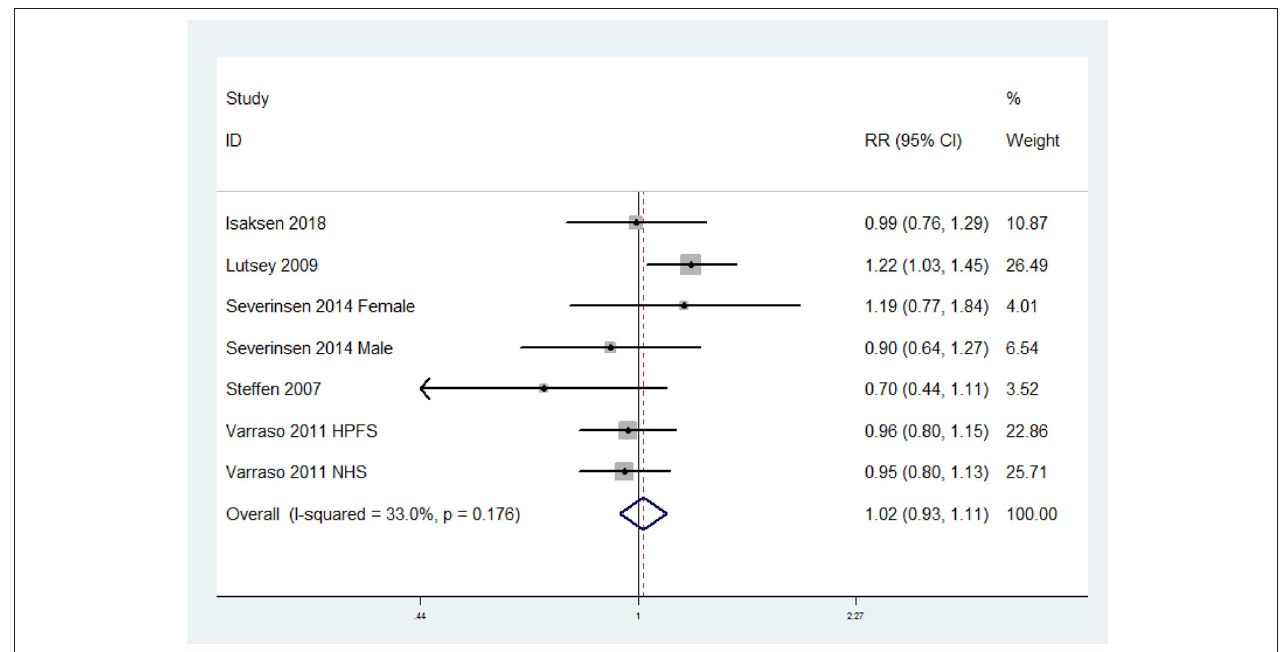
FIGURE 2 | Forest plot of meta-analysis: Overall multi-variable adjusted RR of VTE for the highest vs. lowest category of fish consumption.